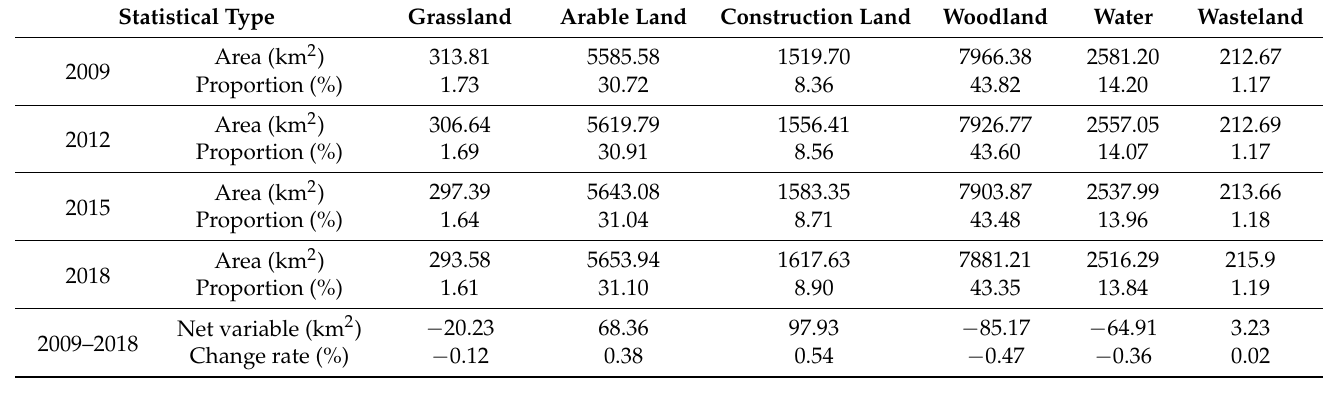
Table 6. Characteristics of Land Use Structure in Changde from 2009 to 2018.